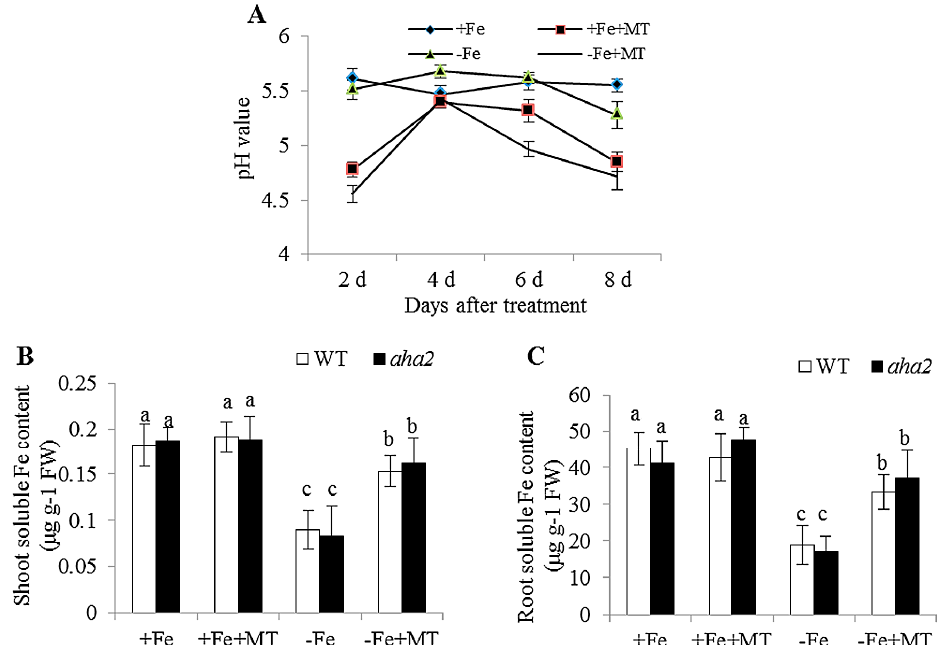
Figure 9. The effect of exogenous melatonin on the pH values of Arabidopsis plants. Seven-day-old seedlings were grown in − Fe (0 µ M Fe) or +Fe (50 µ M Fe) medium (pH = 5.6) without or with the presence of 5 µ M melatonin ( − MT or +MT) for the indicated times for measuring the pH values ( A ). In addition, soluble Fe content of shoots ( B ) and roots ( C ) were determining after seven-day-old WT and aha2 were placed in − Fe or +Fe medium with or without the presence of 5 µ M melatonin for 8 days. Each bar is the mean ± SE of at least three replicates, and different lowercase letters above the bars indicate significant differences using a Tukey’s test at p < 0.05.